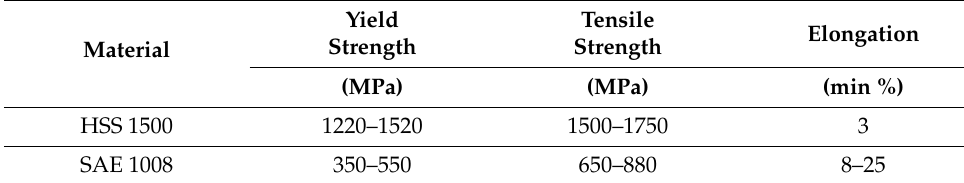
Table 2. Mechanical properties of HSS 1500 and SAE 1008